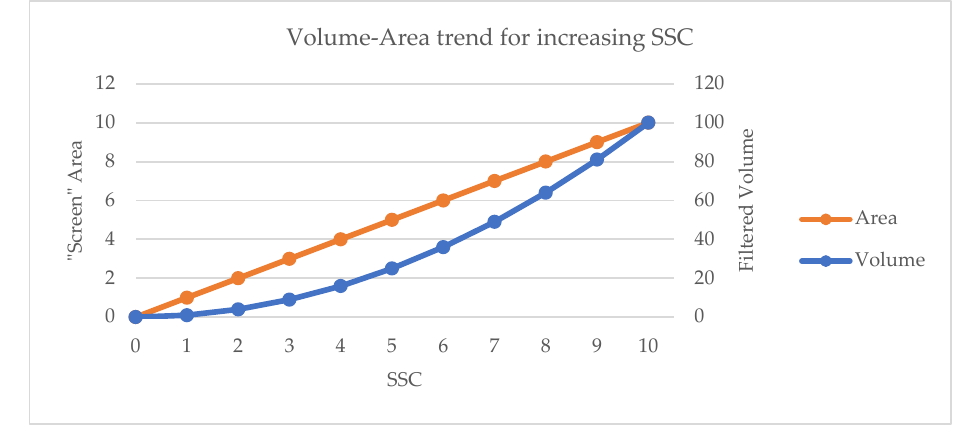
Figure 12. Difference between trends for increasing suspended solids concentration.